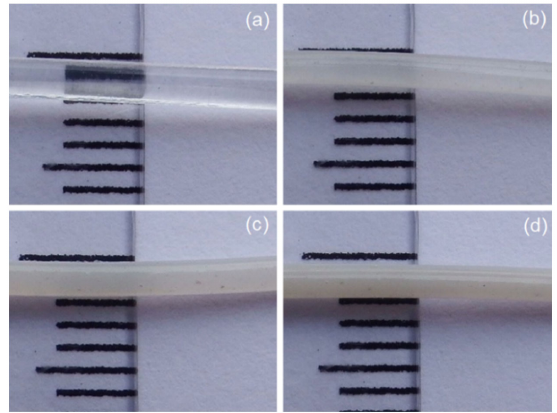
Figure 1. Optical images of 3D printing filaments from ( a ) neat PLA and PLA composited with ZnO nanoflowers at contents of 1 wt% ( b ), 3 wt% ( c ) and 5 wt% ( d ),